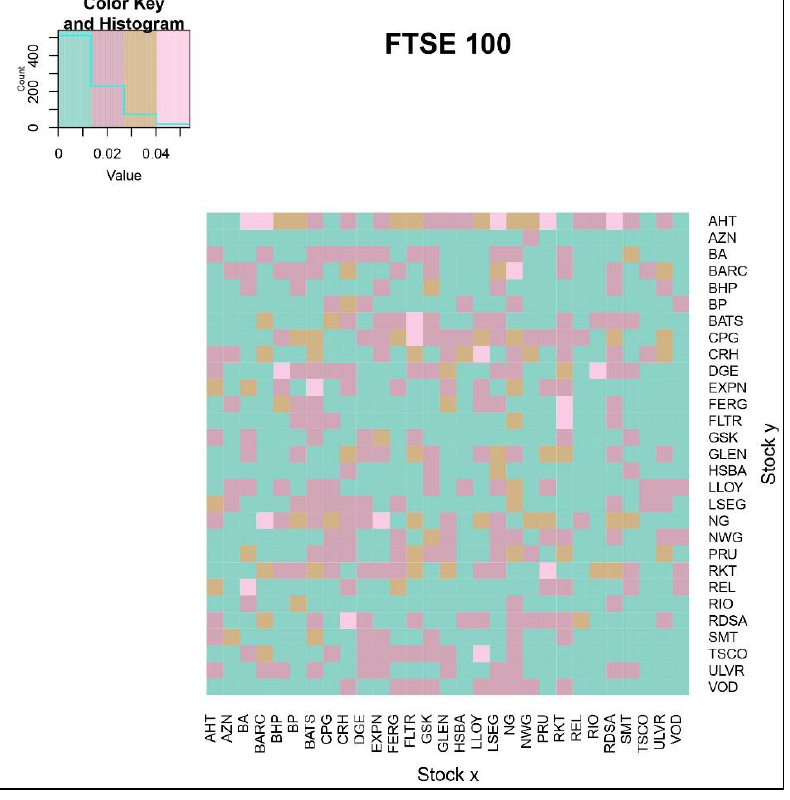
Figure 8. The information flow (effective transfer entropy) from stock y to stock x, for the top companies (by market capitalization) in the FTSE market, after the COVID-19